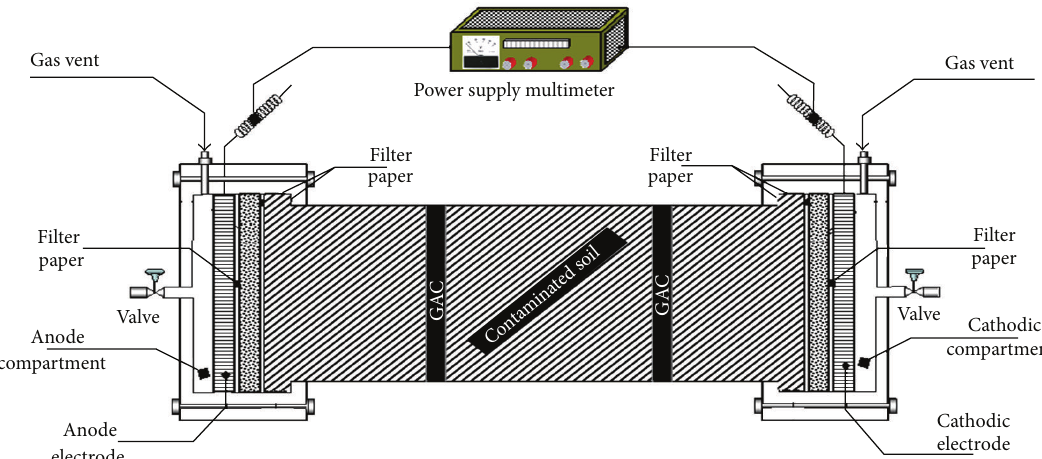
Figure 1: Complete experimental